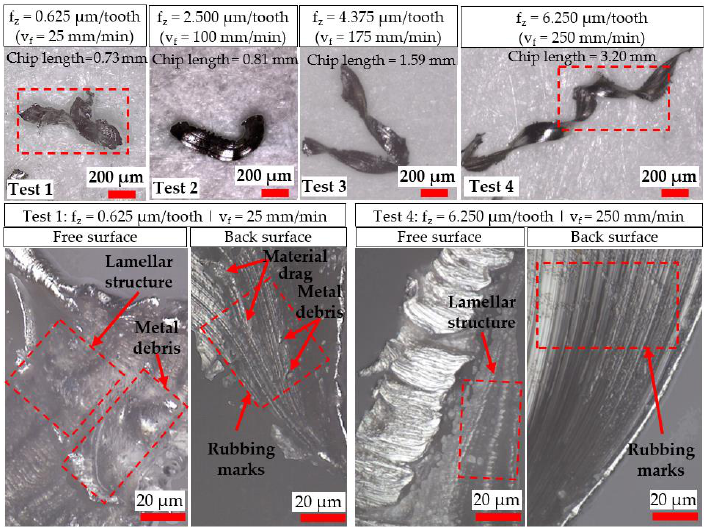
Figure 5. Evaluation of chip morphology from tests performed using Ø 4 mm end-mills.